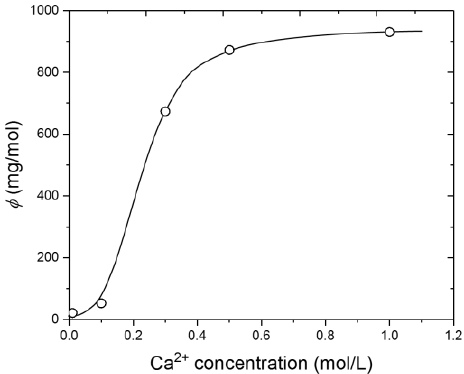
Figure 4. The effect of Ca 2+ concentration on the interaction factor ϕ used in the construction of the fitted curves in Figure 3b.